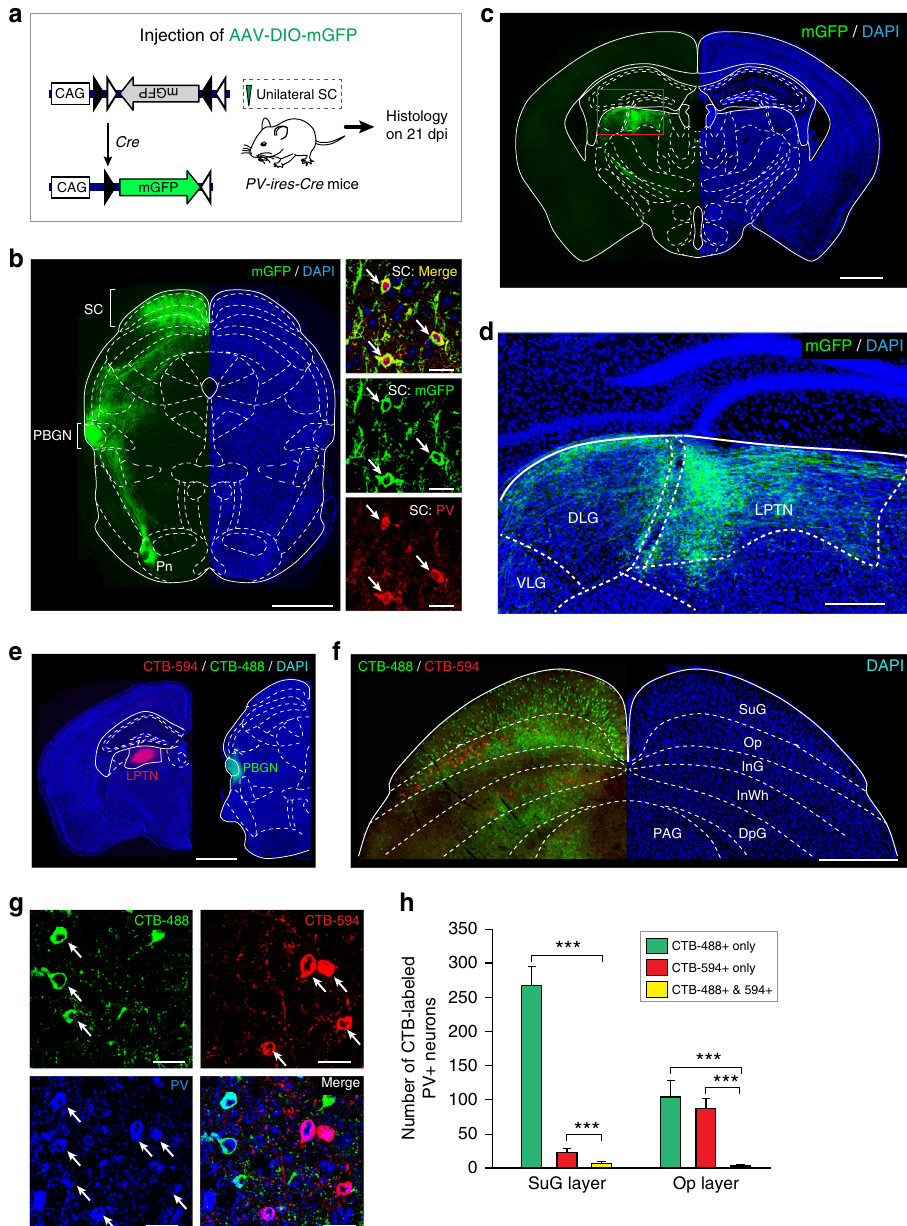
Fig. 3 Distinct SC PV + neurons divergently project to the PBGN and LPTN. a Schematic diagram showing AAV-DIO-mGFP injection into the SC of PV-ires- Cre mice. b Coronal section (left) and example micrographs (right) showing speci fi c expression of mGFP in SC PV + neurons. Arrows indicate PV + neurons. Scale bars, 1 mm (left) and 30 μ m (right). For quantitative analyses, see Supplementary Fig. 4a. c , d Coronal section ( c ) and its cropped region ( d ) showing mGFP + axon terminals of SC PV + neurons in the LPTN and other adjacent thalamic nuclei. For the whole-brain mapping of SC PV + neuron targets, see Supplementary Fig. 4a and 4b. Scale bars, 1 mm ( c ) and 200 μ m ( d ). e Schematic diagram showing ipsilateral injection of CTB-594 into the LPTN and CTB- 488 into the PBGN of the same mice. Scale bar, 1 mm. f Example coronal section of the ipsilateral SC showing the distribution of retrogradely labeled cells projecting to the PBGN (CTB-488 + , green) and LPTN (CTB-594 + , red). Scale bar, 0.5 mm. For single-channel micrographs, see Supplementary Fig. 4c. g Example micrographs from Op layer showing a large proportion of PBGN-projecting (CTB-488 + ) and LPTN-projecting neurons (CTB-594 + ) were positive for PV. Arrows indicate CTB-488 + and CTB-594 + neurons that are also positive for PV. Scale bars, 25 μ m. h Quantitative analyses of the laminar distribution of SC PV + neurons projecting to the PBGN (CTB-488 + ) and LPTN (CTB-594 + ). Data in ( h ) are means ± SEM (error bars, n = 3 mice). Statistical analysis was Student ’ s t test (*** P < PBGN and LPTN neurons respond to looming visual stimuli . a signi fi cant decrease in locomotion speed during and after light + Our data, at this point, indicated that SC PV stimulation (Fig. 5k). Thus, the behavioral patterns induced by neurons, as a key optogenetic activation of the PV + SC-PBGN and PV + SC-LPTN neuronal subtype in the SC, send threat-relevant visual signals pathways roughly mimicked the dimorphic defensive behaviors divergently to the PBGN and LPTN to trigger Type I and Type II triggered by looming visual stimuli. defensive behaviors, respectively. How the PBGN and LPTN